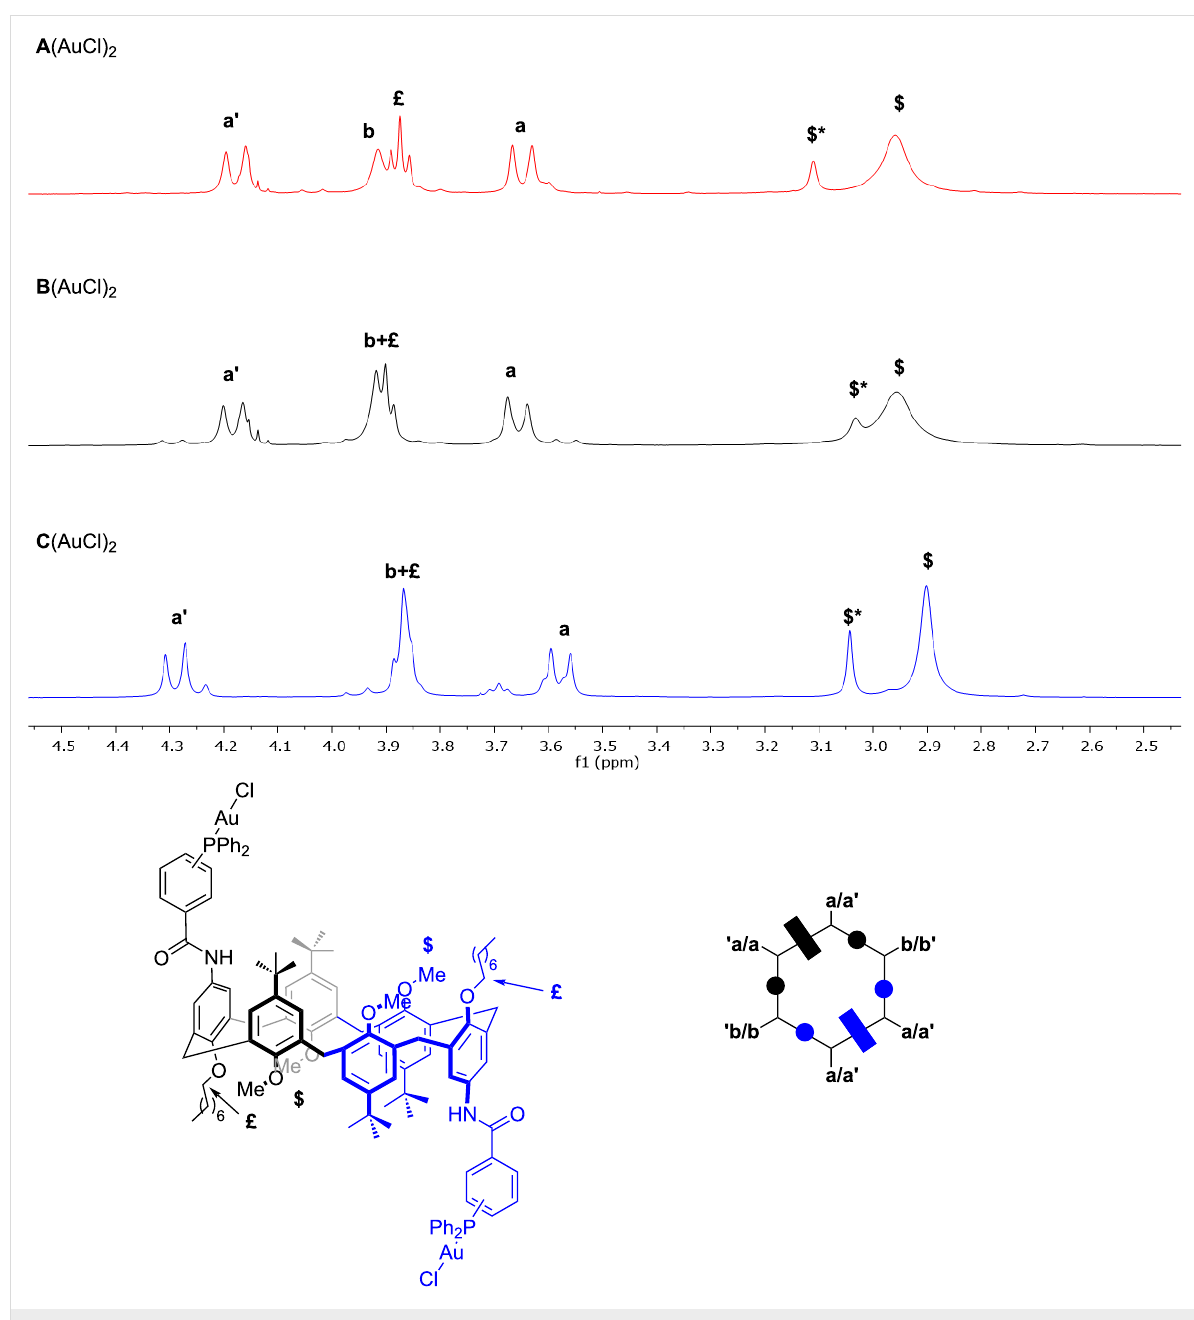
Figure 2: Stacked-plot, mid-field expanded region of the 1 H NMR spectrum (400 MHz, 298 K) of A (AuCl) 2 , B (AuCl) 2 , and C (AuCl) 2 in CDCl 3 . At the bottom are schematic representations of calix[6]arene macrocycles. The rectangle identifies the phenolic ring substituted with the octyloxy chains, while the circle identifies those with methoxy